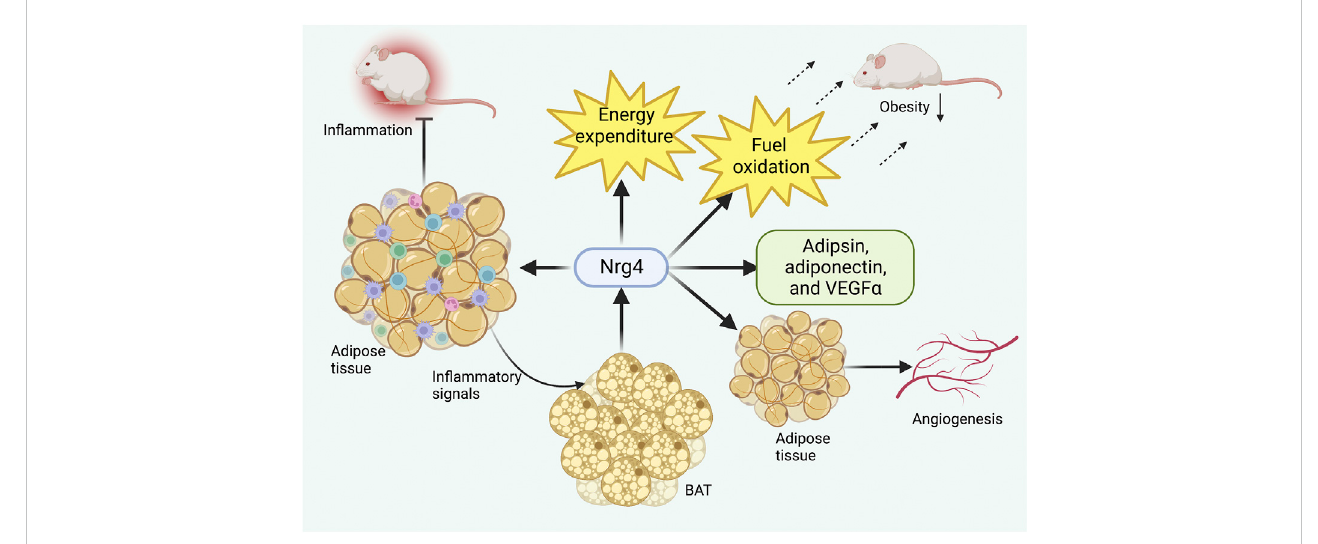
FIGURE 3 RoleofNrg4inobesity.Chronicin fl ammationofadiposetissuecanactivateBATtoproduceNrg4,whichinturnamelioratesadiposetissuein fl ammatory in fi ltration. Nrg4 can promote energy metabolism by increasing energy expenditure and fuel oxidation, together with facilitating the production of metabolically bene fi cial adipokines. Finally, Nrg4 can improve obesity by promoting adipose tissue angiogenesis. Abbreviations: Nrg4, neuregulin four; BAT, brown adipose tissue; VEGF α , vascular endothelial growth factor α